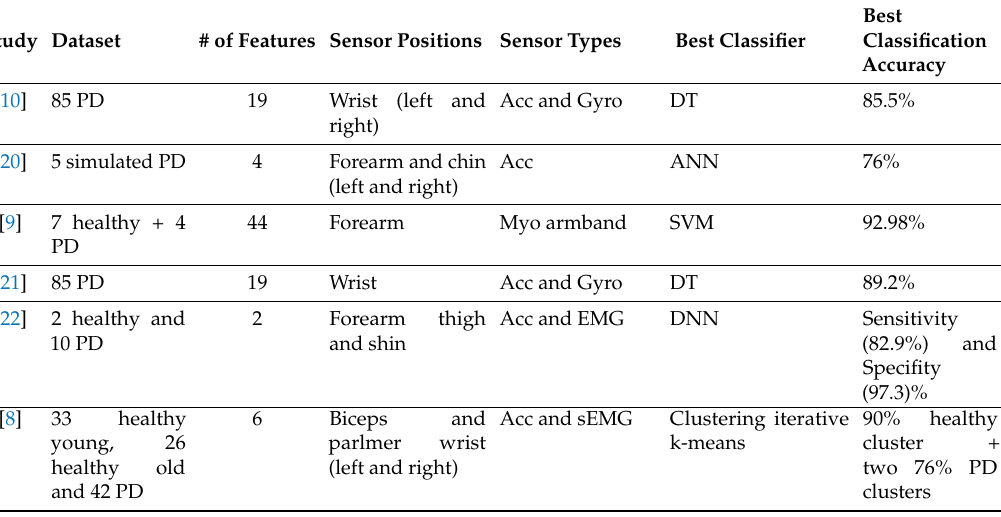
Table 1. Summary of the different techniques from the literature that are similar to the proposed work.